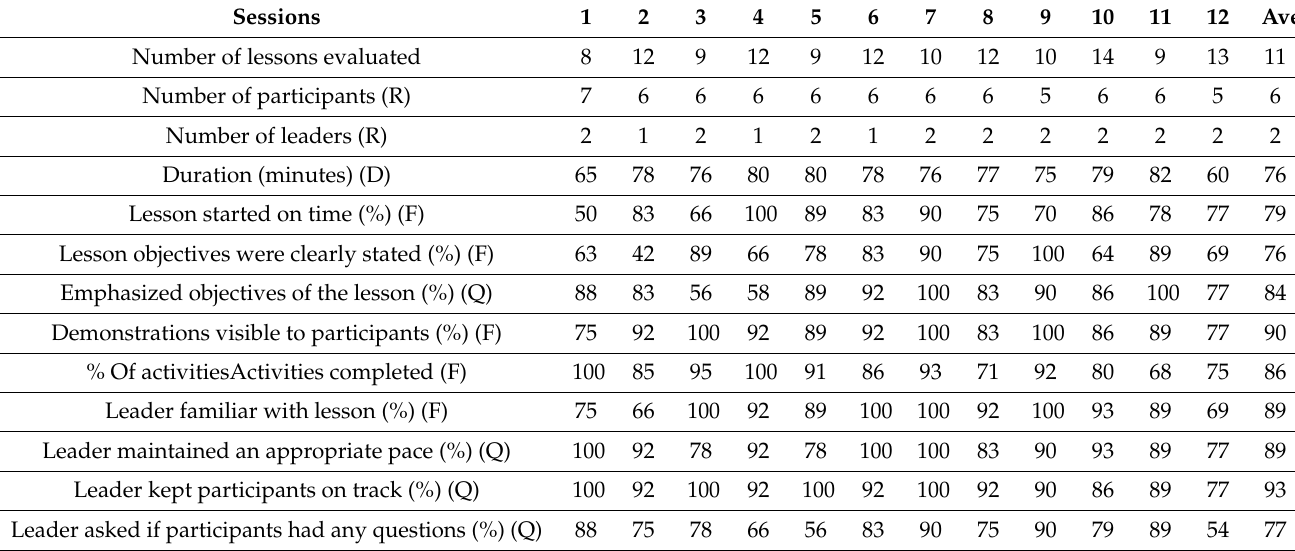
Table 2. Process evaluation (dose (D), reach (R), fidelity (F), quality (Q)). Results of adult-led